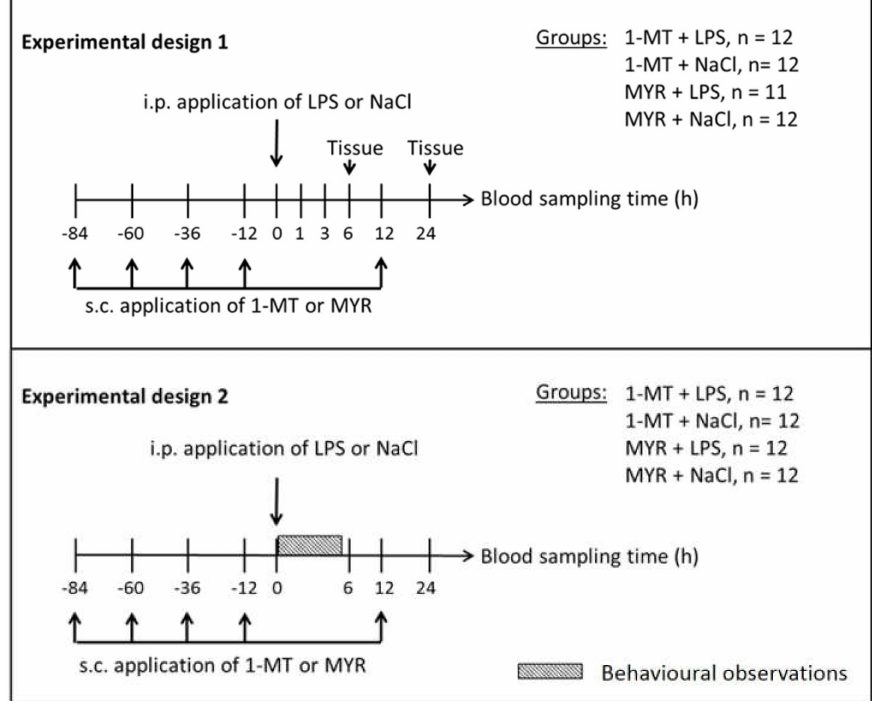
Figure 6. The effects of 1-MT application on TRP metabolism and LPS-induced immune response were investigated in two experiments. In both experiments, 1-MT and its control MYR were repeatedly injected subcutaneously (s.c.) as indicated, aiming at maximum levels of 1-MT at the time of LPS or NaCl injections at 0 h according to the 1-MT kinetics. In experiment 1 ( n = 47), blood samples were taken before and at 0, 1, 3, 6, 12 and 24 h after LPS/NaCl application and tissue was sampled after 6 h ( n = 24) and after 24 h ( n = 23). In experiment 2 ( n = 48), blood samples were taken before and at 0, 6, 12 and 24 h after LPS/NaCl application and behaviour was observed in the period from 0 to 5 h. Both experiments were conducted in three replicates with 15 or 16 animals